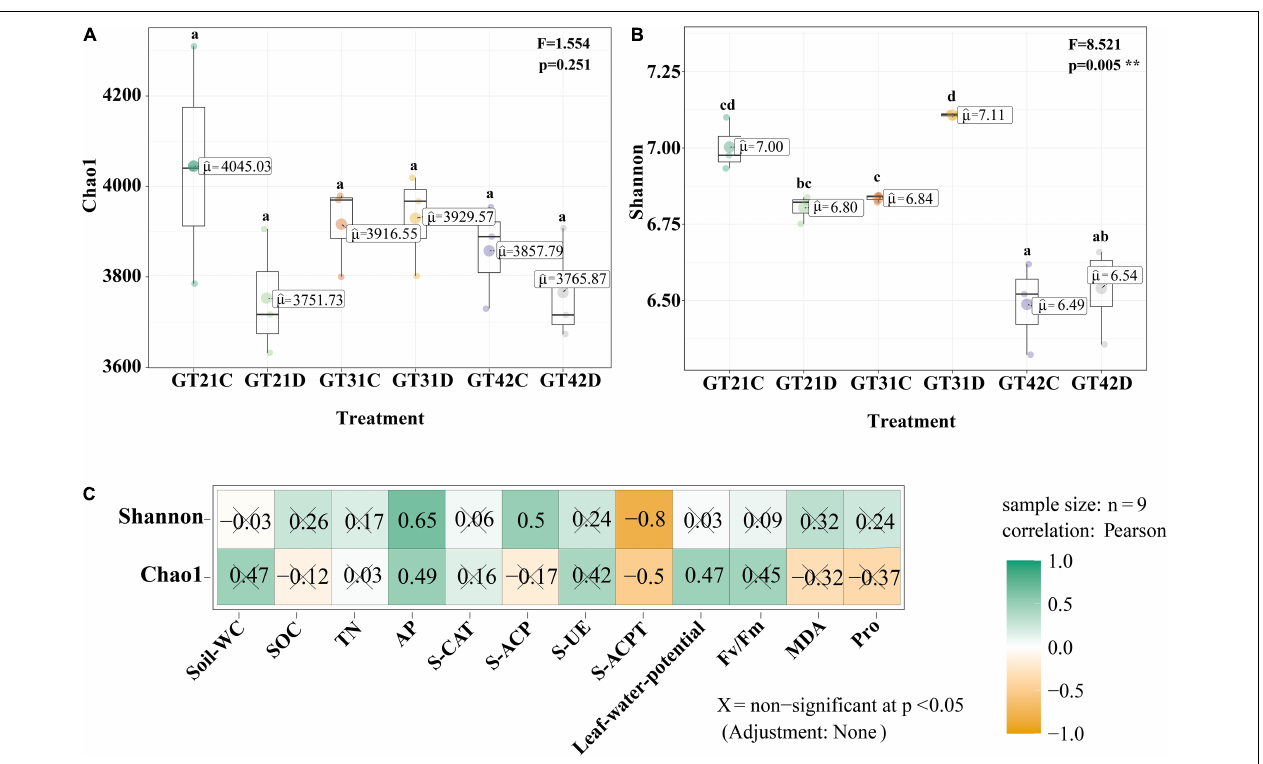
FIGURE 1 | Alpha diversity of rhizosphere microbial community. (A) Chao 1 index of α -diversity showed the species richness of rhizosphere microbial community among different treatments. (B) α -diversity Shannon index showed rhizosphere microbial community diversity among different treatments. Different letters in the figure represent significant differences between treatments ( P < 0.05). GT21, GT31, and GT42 are sugarcane varieties, C is normal watering treatment, D is drought treatment. Soil-WC, Soil water content; SOC, Soil organic carbon; TN, Soil total nitrogen; AP, Soil available phosphorus; S-CAT, Soil catalase; S-ACP, Soil acid phosphatase; S-UE, Soil urease; S-ACPT, Soil acid protease; Fv/Fm , Chlorophyll fluorescence parameter; MDA, malondialdehyde; Pro, proline. (C) Correlation analysis between α diversity index and environmental factors (X = non-significant at P < 0.05).